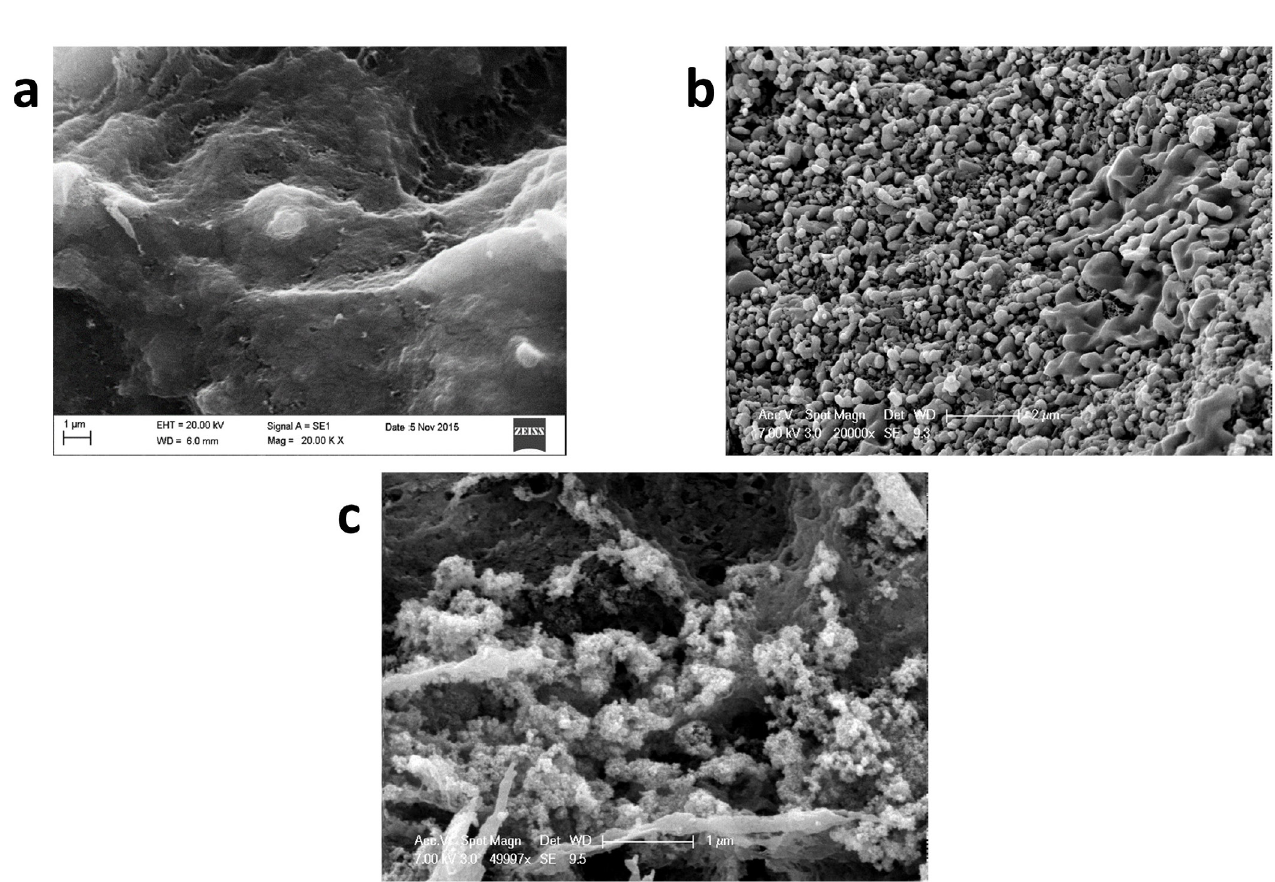
FIGURE 2 - SEM images of chitosan nanobeads (a) Chitosan nanobeads could not be formed in the presence of TPP salt (b) Roughly 300 nm of chitosan nanobeads were formed in the presence of Na and wide size distribution (c) Chitosan nanobeads formed in the presence of Na have comparably smaller size (20